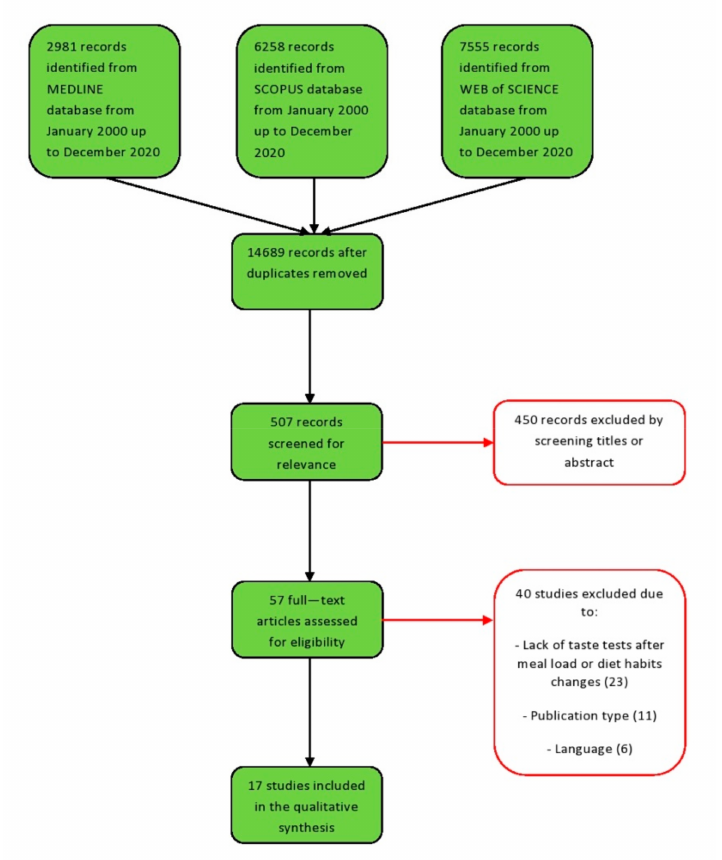
Figure 1. Selection process for the studies included in the scoping review. The Preferred Reporting Items for Systemic Reviews and Meta-Analyses for scoping reviews [PRISMA-sc (according to Tricco et al. [35])] flow diagram depicts the number of records identified, included, and excluded, and the reasons for exclusion, through the different phases of the scoping